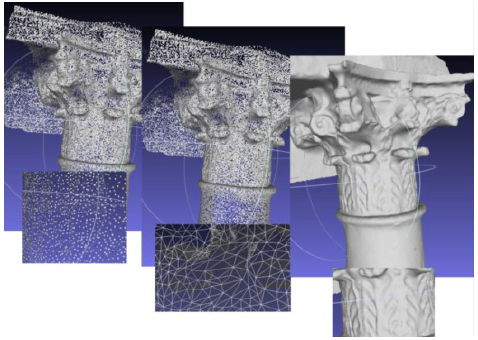
Figure 9: Point Cloud to Triangulation to Surface Ortho-image